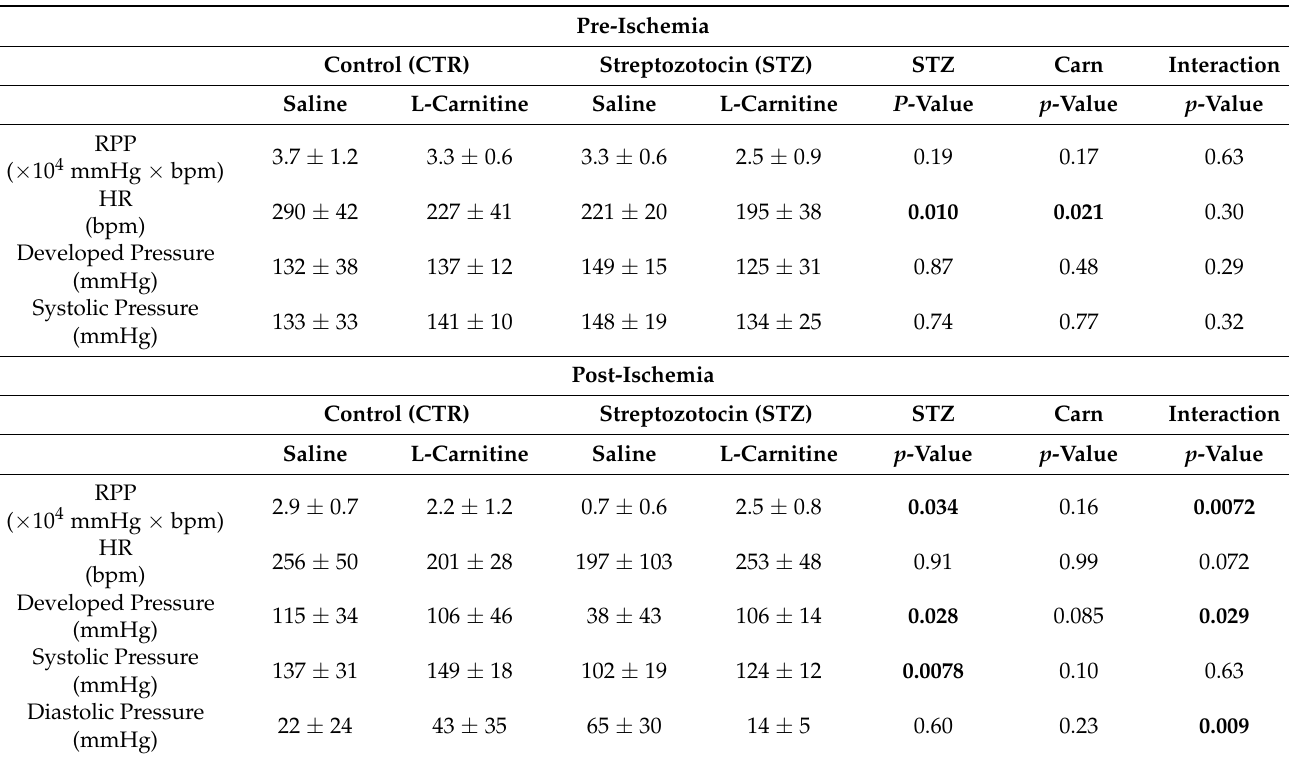
Table 3. Langendorff perfusions. Functional parameters obtained pre- and post-ischemia in control (CTR) and diabetic (STZ) animals using a Langendorff ischemia-reperfusion method. Data are presented as mean ± SD. Two-way ANOVA. p -value displayed with the effect of streptozotocin (STZ), the effect of L-carnitine (Carn) and the interaction between